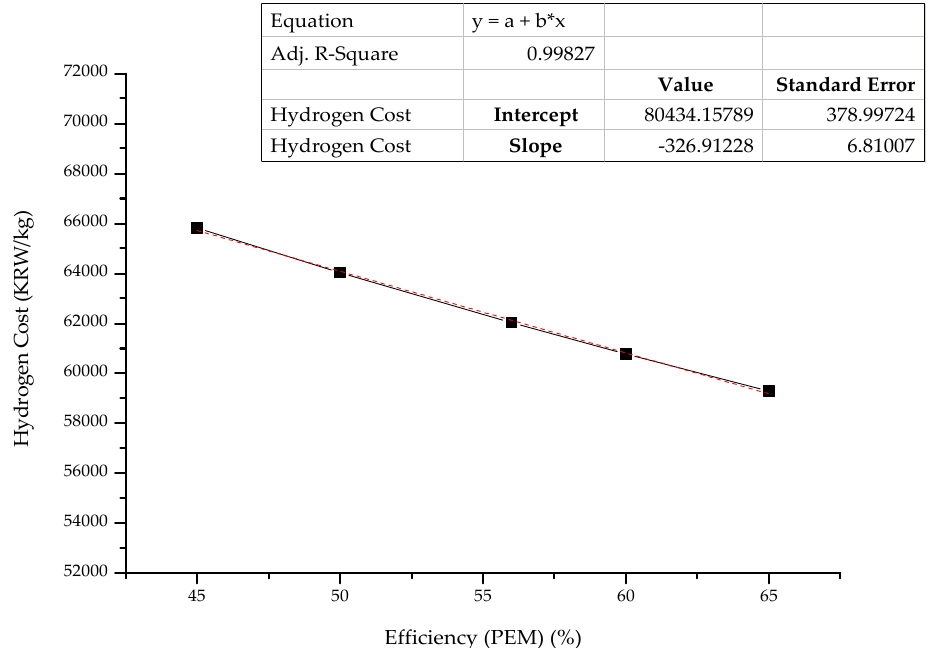
Figure 6. Correlation between efficiency of water electrolysis (PEM type) and hydrogen cost *. * x -axis: Efficiency for PEM-Type Water Electrolysis (%), y -axis: Hydrogen Cost (KRW/kg). Solid line: y -values connecting line, Dot line: Regression line.